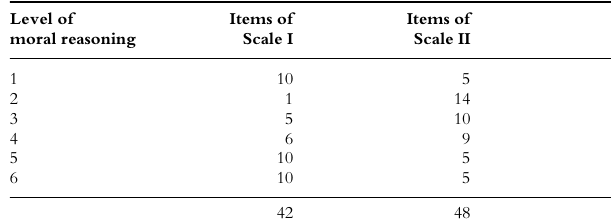
TABLE 8 ITEMSOF SCALES I ANDII